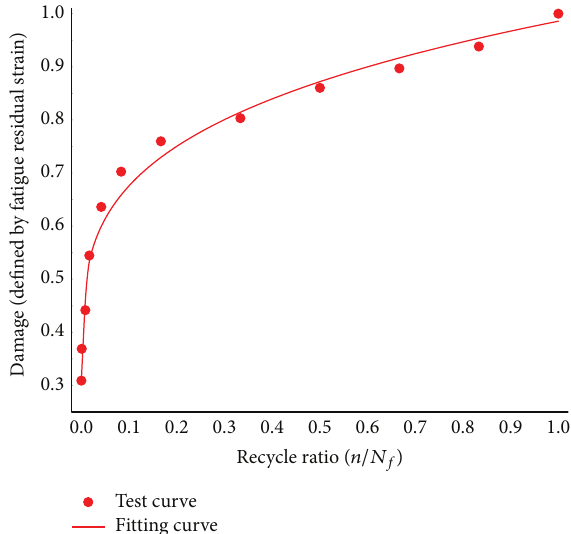
Figure 8: Damage result of JL-4 based on maximum fatigue strain.